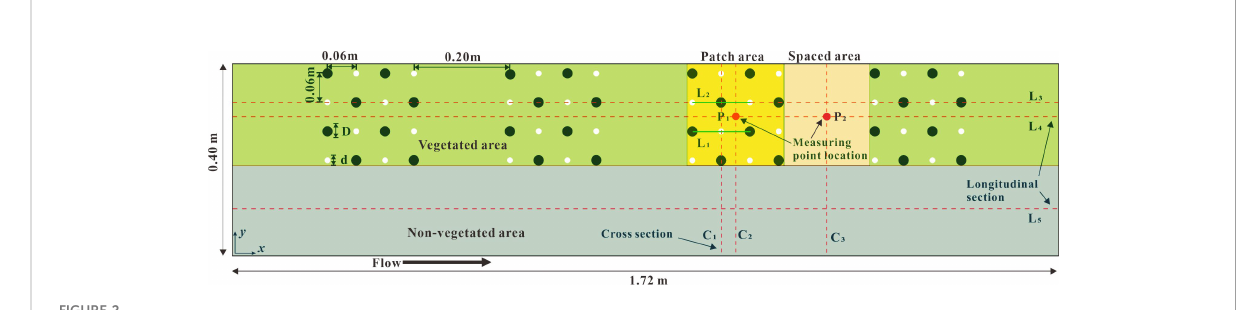
FIGURE 2 Schematic diagram of fl oor layout in numerical calculation